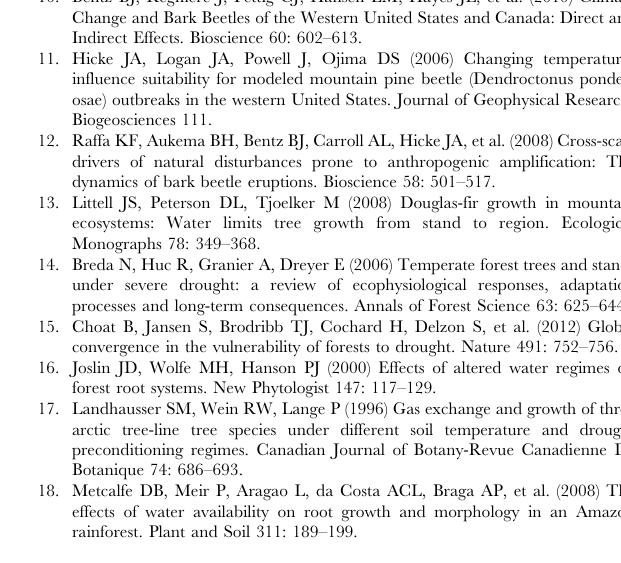
33,594 grid points using Ordinary Kriging. Figure S5 Projected Changes in Mortality Rate for Sierra Nevada Conifer Forests (PCM B1, Hypothetical). Mapped projections of average relative changes in mortality rate for the years 2090 to 2099 for coniferous forests of California’s Sierra Nevada, using exponential and the PCM B1 emissions model. Elevations generally increase from left to right. (A) Changes in mortality when absolute changes in deficit ( D a ) are used as a predictor. (B) Changes in mortality when relative changes in deficit ( D r ) are used as a predictor. Surfaces were interpolated from 33,594 grid points using Ordinary Kriging. Figure S6 Projected Changes in Mortality Rate for predomi- nantly Energy-Limited Sierra Nevada Conifer Forests (GFDL B1, Hypothetical). Mapped projections of average relative changes in mortality rate for the years 2090 to 2099 for energy-limited coniferous forests ( $ 2450 m) of California’s Sierra Nevada, using exponential models and the GFDL B1 emissions model. Elevations generally increase from left to right. (A) Changes in mortality when absolute changes in deficit ( D a ) are used as a predictor. (B) Changes in mortality when relative changes in deficit ( D r ) are used as a predictor. (C) Changes in mortality when absolute changes in temperature (T a ) are used as a predictor. Figure S7 Projected Changes in Mortality Rate for predomi- nantly Energy-Limited Sierra Nevada Conifer Forests (PCM A2, Hypothetical). Mapped projections of average relative changes in mortality rate for the years 2090 to 2099 for energy-limited coniferous forests ( $ 2450 m) of California’s Sierra Nevada, using exponential models and the PCM A2 emissions model. Elevations generally increase from left to right. (A) Changes in mortality when